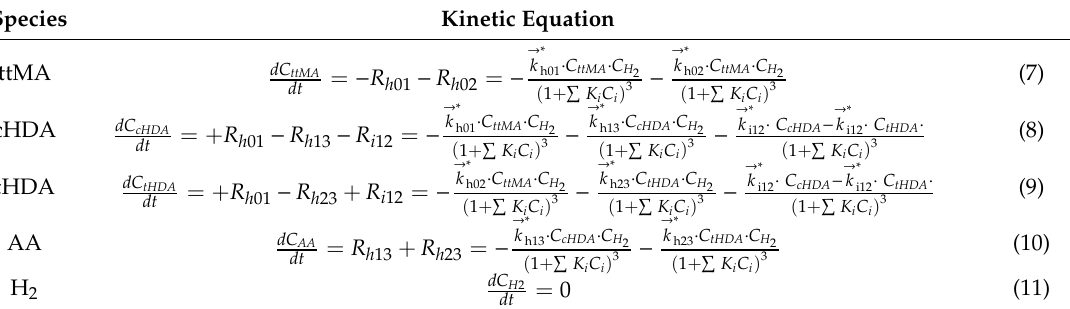
Table 2. Material balance equations solved for the model LHHW_17P.